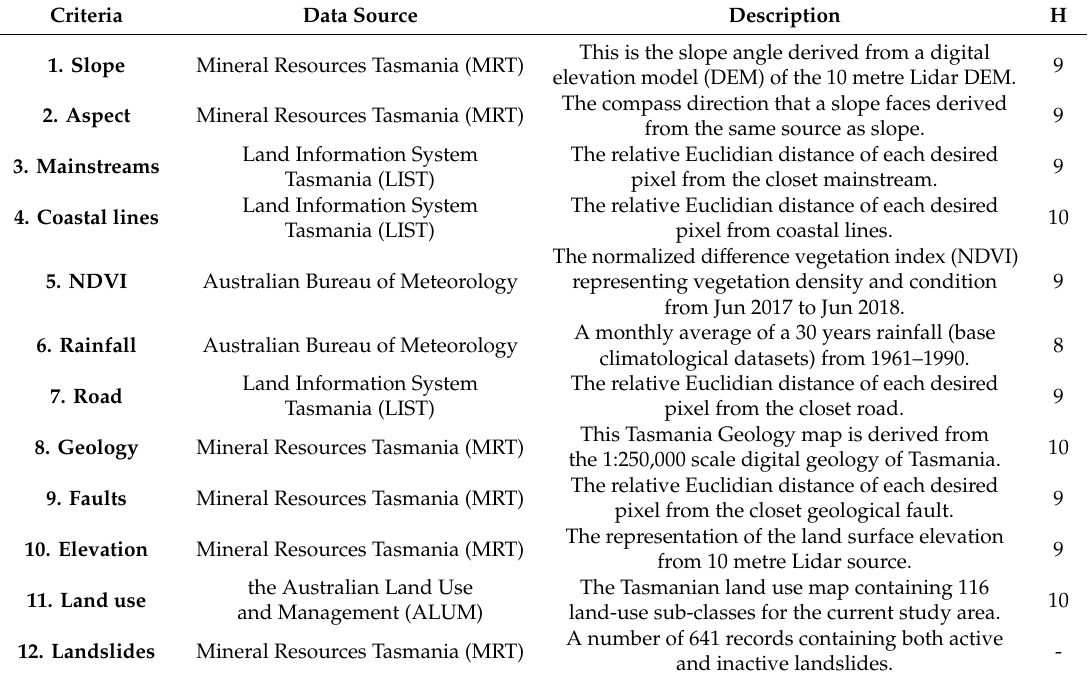
Table 1. Selected landslide-conditioning factors based on literature review, relevant data source, description and number of discrete classes